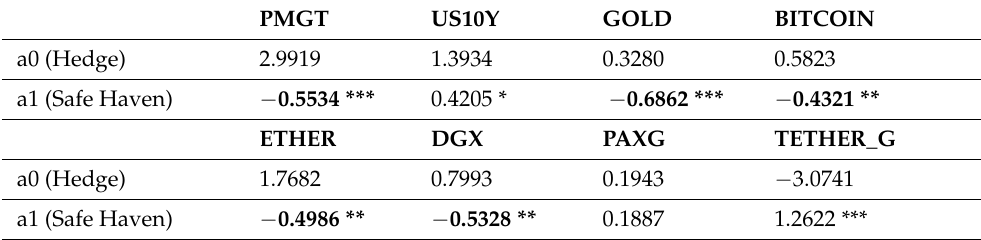
Table 2. Regression results from bivariate cDCC safe-haven regressions à la